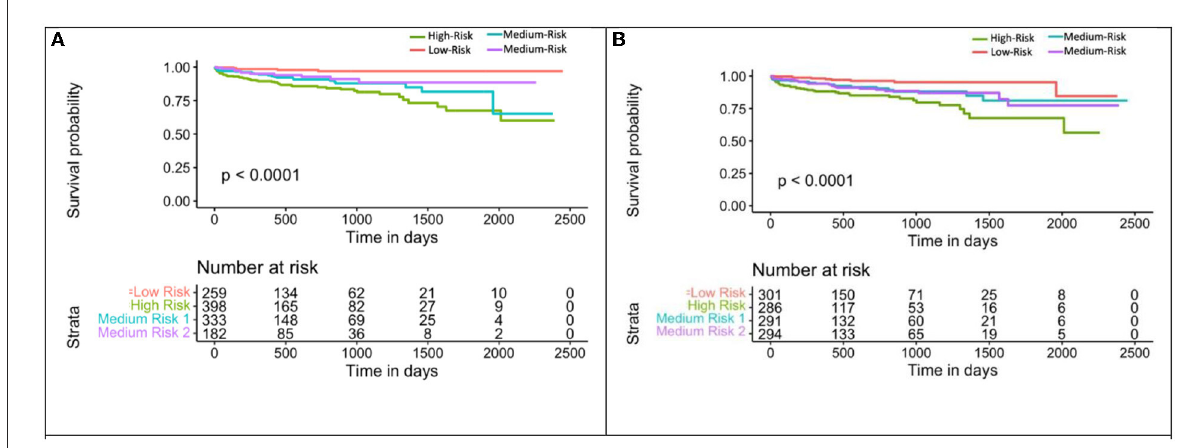
FIGURE7 Kaplan-Meier plot for MACE-free survival according to eRiS + CAC and eRiS only risk groups in S v (4). (A) The eRiS + CAC threshold showed worse prognosis for patients with high eRiS combined with high CAC score. HR between high and low risk: 6.72 [4.42–10.22]. (B) Similar observation seen in eRiS based segregation. HR between high and low risk: 5.22 [2.54–10.75].